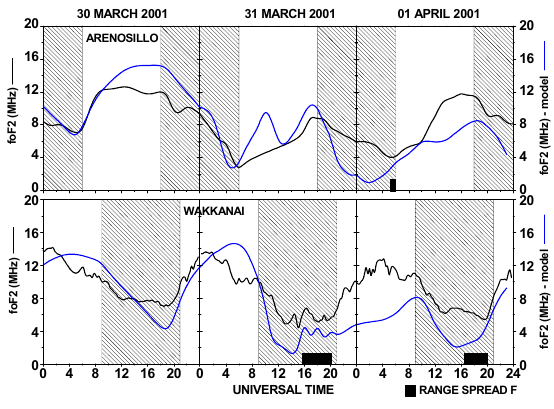
Figure 4b Fig. 4b. Same as in Fig. 2b, but for mid-latitude stations El Arenosillo and Wakkanai, except hm F2 at El